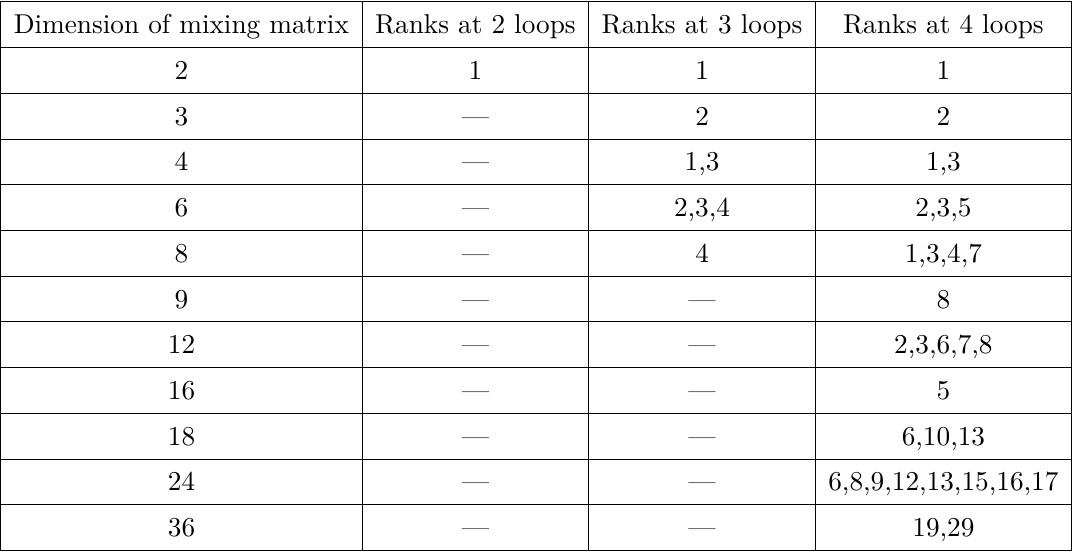
Table 2. Dimension and the corresponding ranks of mixing matrices at different perturbative